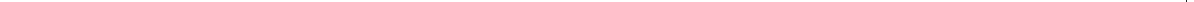
Frontiers in Cell and Developmental Biology |